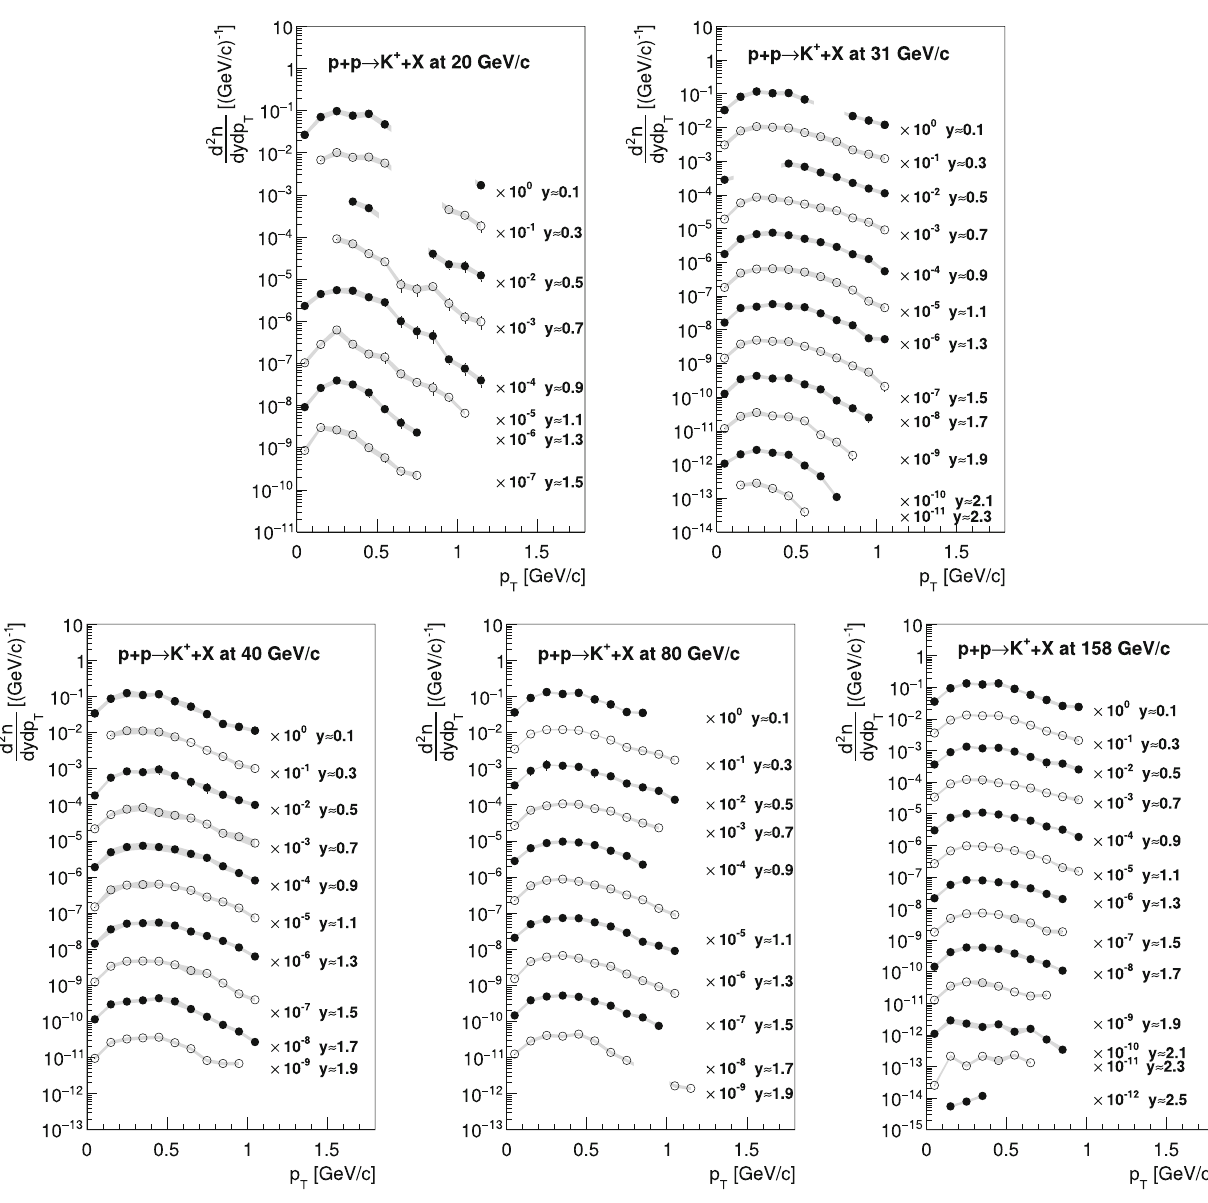
Fig. 27 Transverse momentum K + spectra in rapidity slices produced in inelastic p + p interactions at 20, 31, 40, 80, 158 GeV / c . Rapidity values given in the legends correspond to the middle of the corresponding interval. Shaded bands show systematic